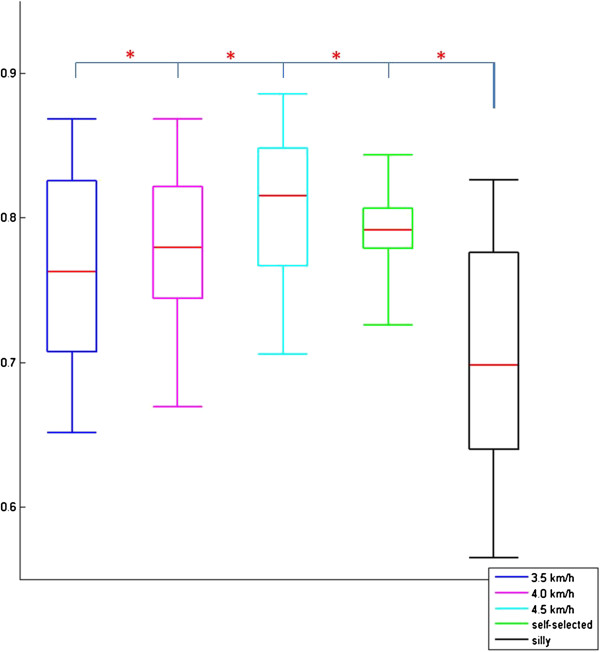
Correlation coefficients (R) at different speeds and silly walks. The tops and bottoms of the boxes are the 25th and 75th percentiles of R respectively. Red lines indicate the median values. (*) denotes significant difference.